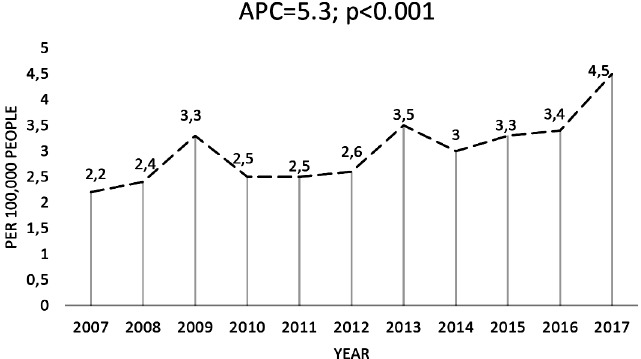
Figure 8. Syphilis incidence rates in the years